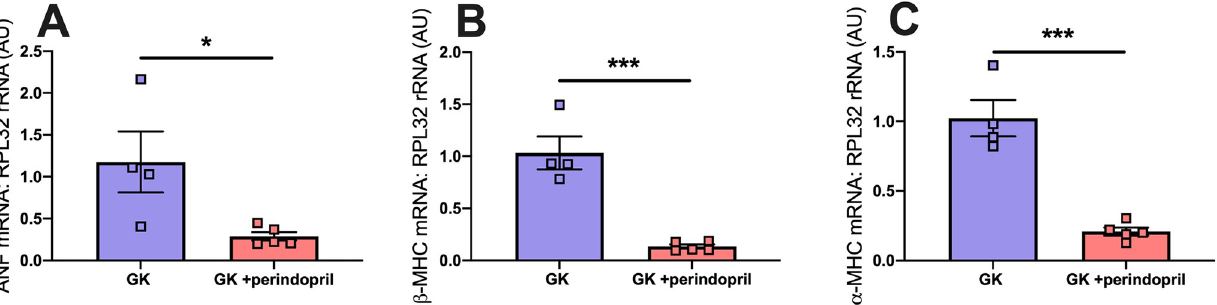
Fig 7. RT-qPCR analysis of cardiac genes in control GK and GK rats treated with perindopril. (A) Atrial natriuretic Factor, (B) beta-Myosin Heavy Chain ( β -MHC), (C) alpha-myosin heavy chain ( ⍺ -MHC). Where hearts tissue of Goto Kakizaki rats either treated with saline (GK) or ACE inhibitor perindopril (GK + perindopril) were analysed. Where � = p < 0.05, when compared to GK (students t-test was used to assess statistical significance).